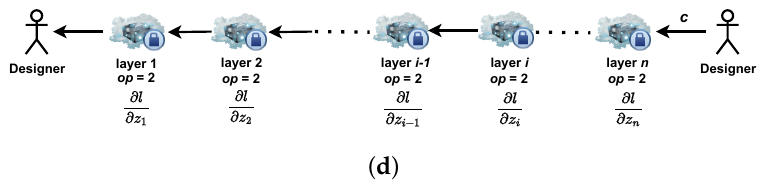
Figure 2. Training phase ( c is the ciphertext). ( a ) A cascade is constructed. The designer distributes layers on different servers and each layer generates its key pairs and its IP address. ( b ) Model initialization phase. The designer deploys the size of parameters, parts of the model and optimizer on the corresponding layers. ( c ) Forward propagation phase. The designer inputs data into the first layer and the supervised signal into the last layer. Except for the last layer, each layer needs to compute Z i . The last layer should compute the loss l . ( d ) Backward propagation phase. For layer i , layer i updates its parameters W i using intermediate gradient ∂ l from the previous layer, and prepares ∂ l for the ∂ z i ∂ z i − 1 next